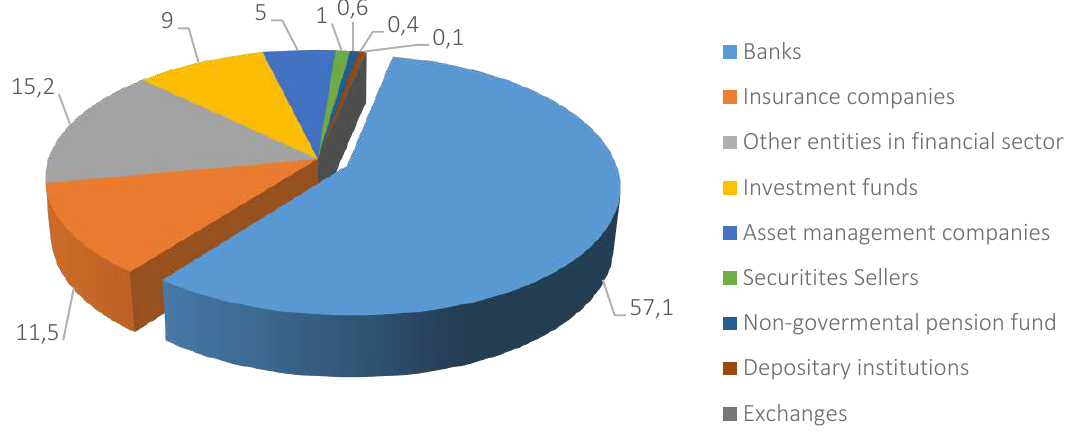
Figure 3. Structure of financial institutions that are customers of audit services, the share in the total volume of services provided in 2019,